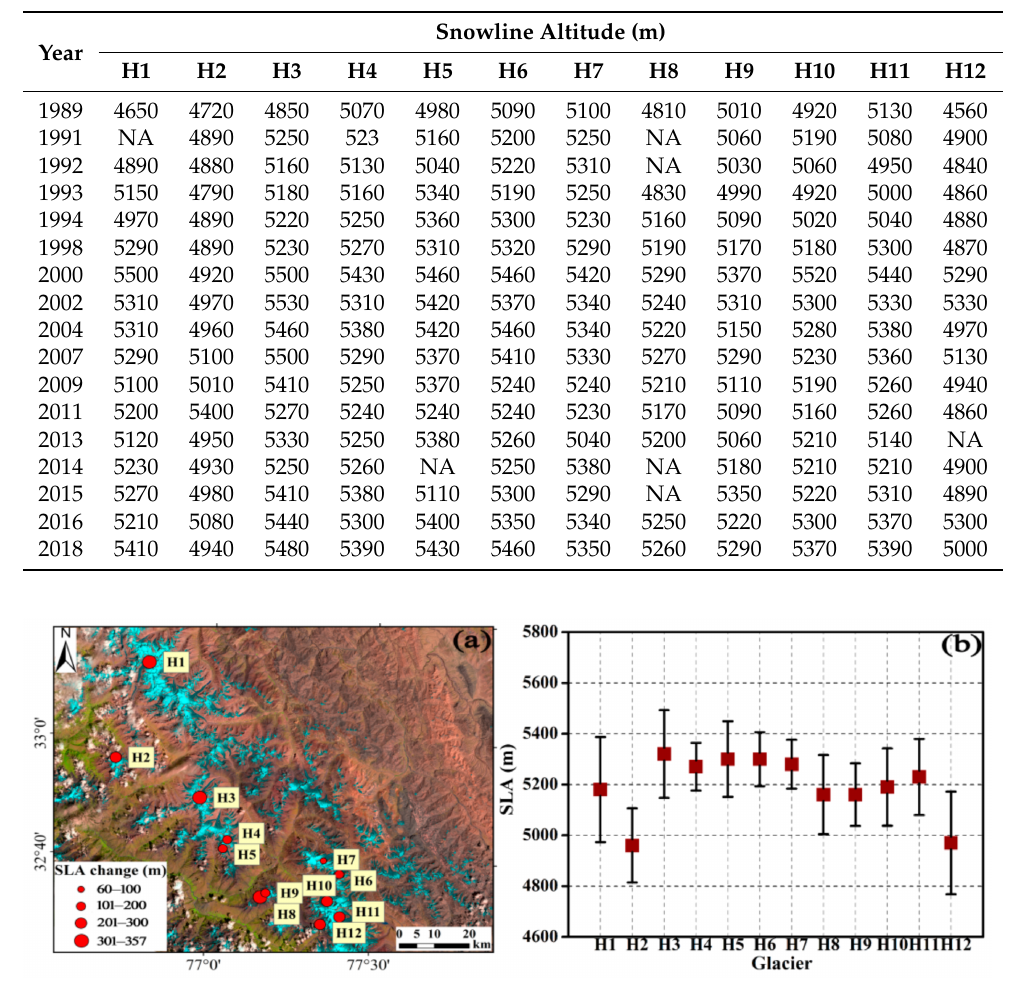
Table 5. SLAs of the 12 analyzed glaciers across the Western Himalayas during the 1989–2018 period.